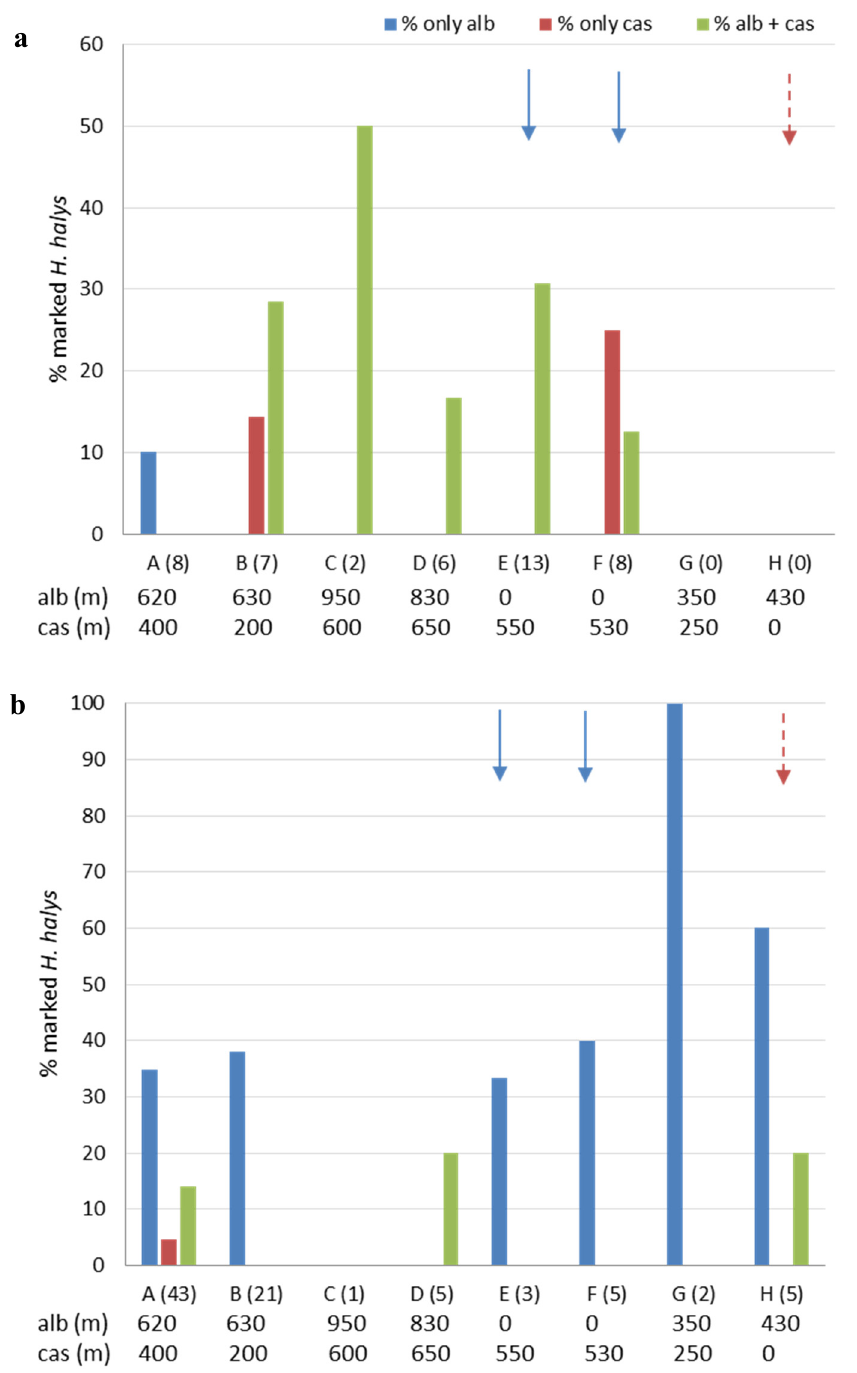
Figure 7. Total percentages of marked Halyomorpha halys adults collected in the sampling zones (A–H) of Area 3 from 5 April to 27 April ( a ) and from 28 April to 30 May ( b ). On the x-axes for each zone the total number of tested specimens is given in brackets. For each zone, the distance (meters) from the treatment site is also indicated either for albumin (“alb”) or casein (“cas”). Arrows designate the zones in which treatments with casein (dashed dark red arrow) and albumin (blue arrow) were applied.